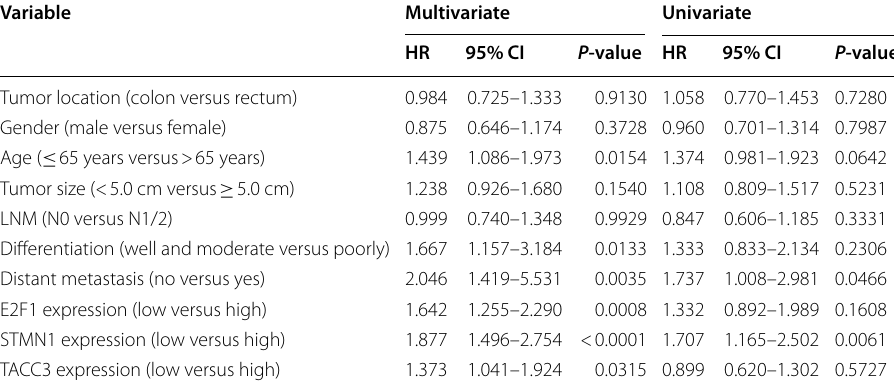
Table 2 Multivariate and univariate analysis of prognostic factors for OS